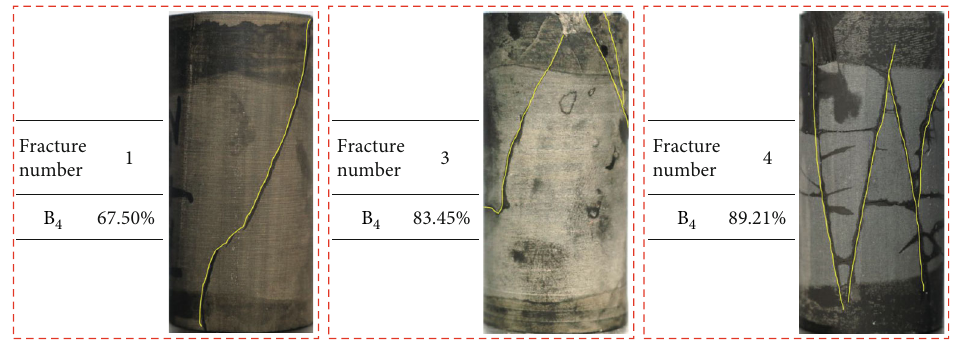
Figure 8: The typical fracture characteristics of shale oil cores after failure.